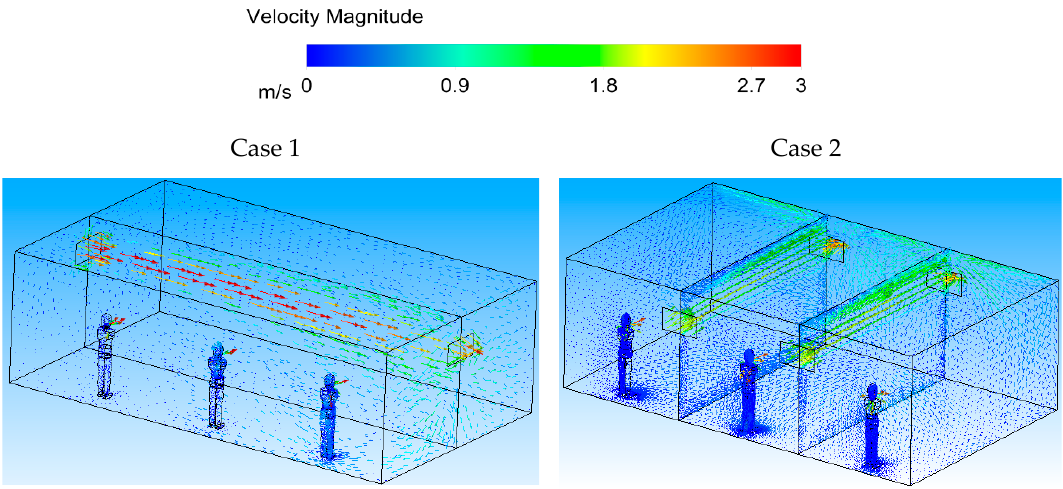
Figure 11. Velocity vector in the middle planes of the space in both cases.